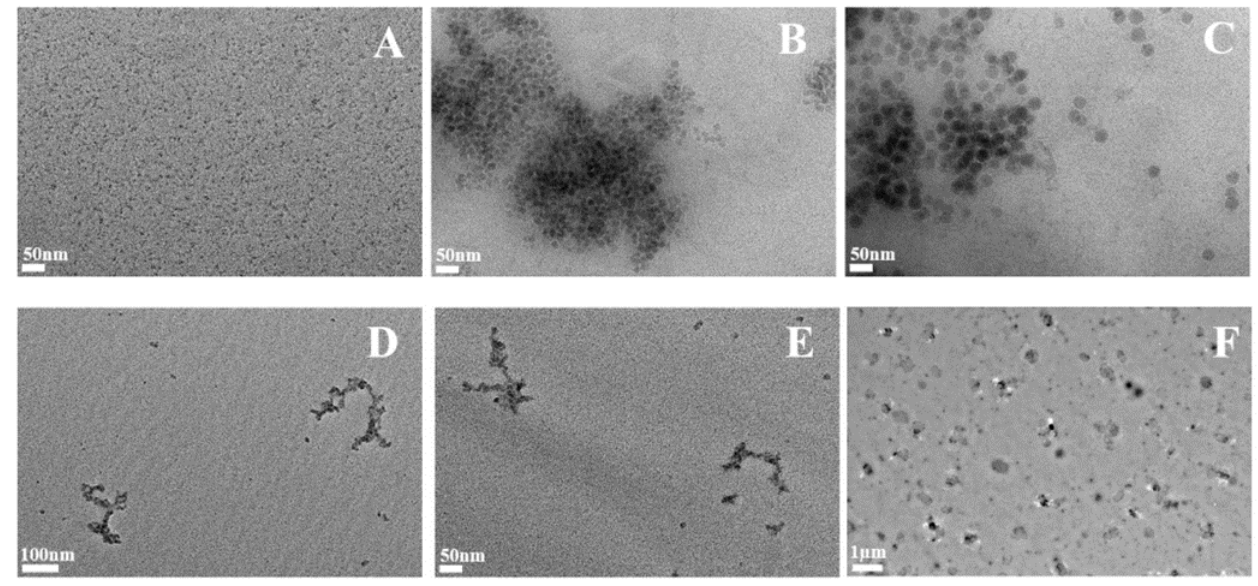
Figure 5. Examination by TEM of SAS extracted from cells. Macrophage cells were exposed to SAS for 24 h and allowed to recover for 72 h. At the end of the culture the cells were recovered, lysed and the lysate digested sequentially by a nuclease and a protease. The clarified lysate was examined by TEM to investigate the state of the internalized SAS. ( A ) control cells (no silica treatment) magnification 30,000×. ( B ) SC: small-particle colloidal silica 220 m 2 /g 30,000×. ( C ) MC: medium-particle colloidal silica 140 m 2 /g 30, 000×. ( D ) SPr: small-particle precipitated silica 220 m 2 /g 23,000×. ( E ) MPr: medium-particle precipitated silica 55 m 2 /g 23,000×. ( F ) SPy: small-particle pyrogenic silica 200 m 2 /g 23,000×.